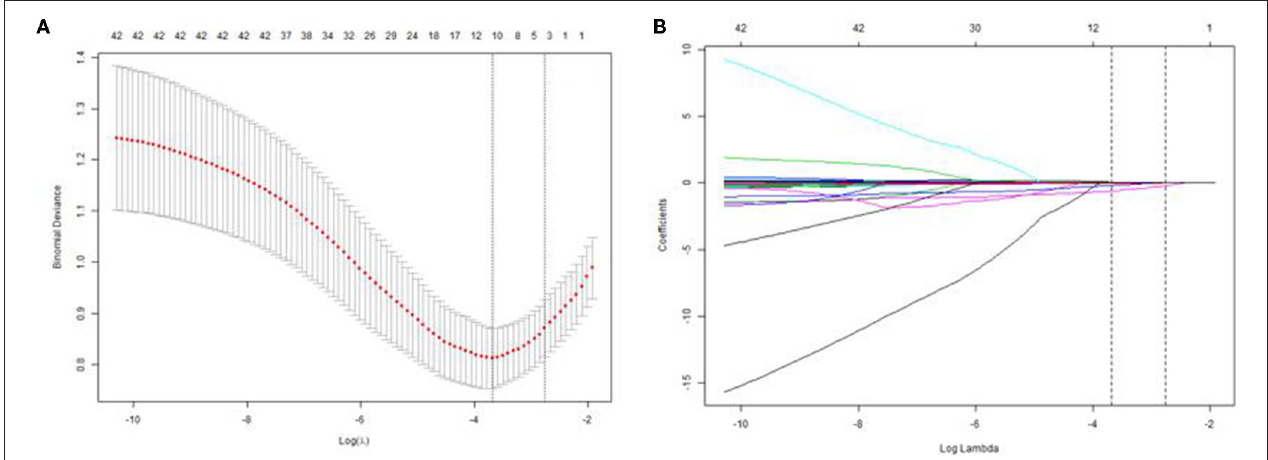
FIGURE 2 | Texture feature selection using LASSO logistic regression and the predictive accuracy of the radiomics signature. (A) Selection of the tuning parameter ( λ ) in the LASSO model via 10-fold cross validation based on minimum criteria. The optimal λ value of 0.0577 with log ( λ ) = − 2.85 was selected. (B) LASSO coefficient profiles of the 25 texture features. The dotted vertical line was plotted at the value selected using 10-fold cross-validation in (A) .